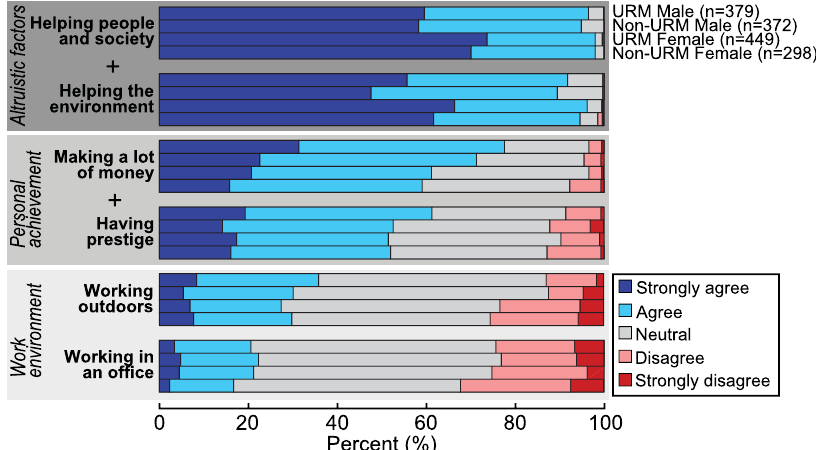
Fig. 2 Survey results from six questions regarding descriptions of their “ ideal career ” using a fi ve-point Likert scale, in which students rated how much they agreed or disagreed with a particular statement. Comparison of results from URM (Hispanic, Black or African American, or Native American) and non-URM (White or Asian) students separated by male and female. Table 1 Differences in average responses from student respondents.